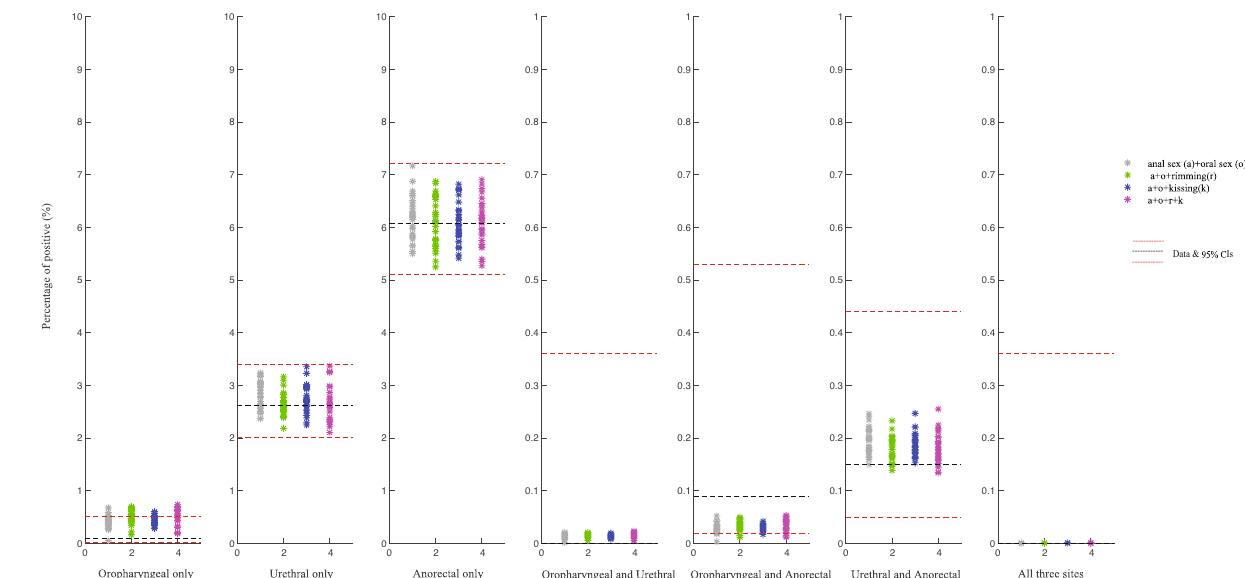
Figure 1. Empirical site-specific positivity data of Mycoplasma genitalium and the positivity data simulated by the four fitted models. The black dotted lines represent the mean empirical site-specific positivity data; The two red dotted lines indicate the 95% CIs for the mean empirical site-specific positivity data; The positivity of oropharyngeal and urethra both and infection at all three sites was zero (mean value and lower 95% CI), and therefore the dashed lines are missing; Model 1 (grey asterisk): Oral sex and anal sex only; Model 2 (green asterisk): Oral sex and anal sex and rimming only; Model 3 (blue asterisk): Oral sex and anal sex and kissing only; Model 4 (purple asterisk): Oral sex and anal sex and rimming and kissing; Oropharyngeal only: infection at the oropharynx only; Urethral only: infection at the urethra only; anorectal only: infection at the anorectum only; oropharyngeal and urethral: infection at both oropharynx and urethra; oropharyngeal and anorectal: infection at both oropharynx and anorectum; urethral and anorectal: infection at both urethra and rectum; all three sites: infection at all three anatomical